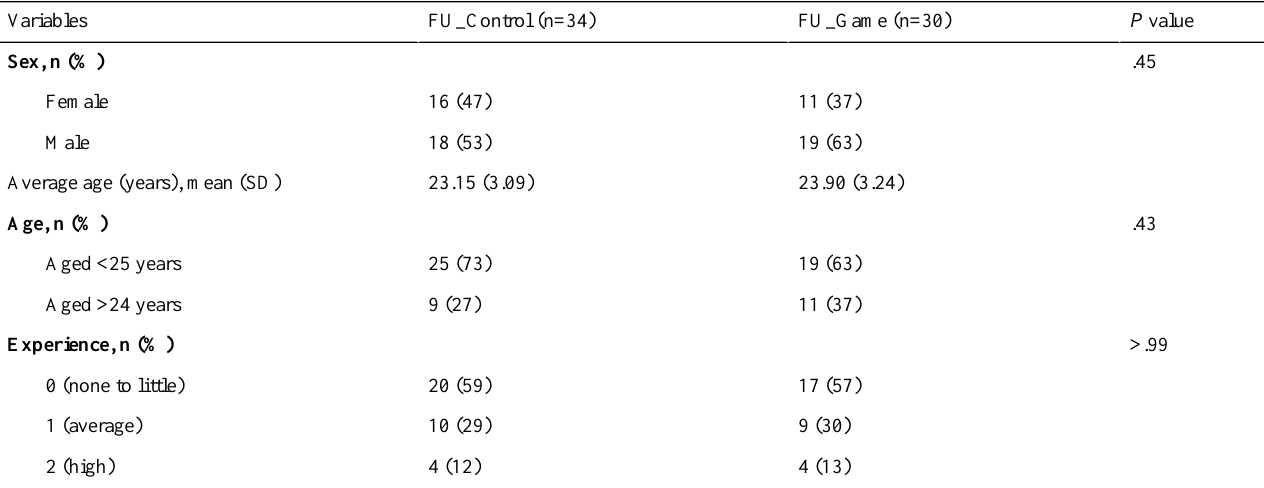
Table 2. Sample description and comparison of study 2 in baseline